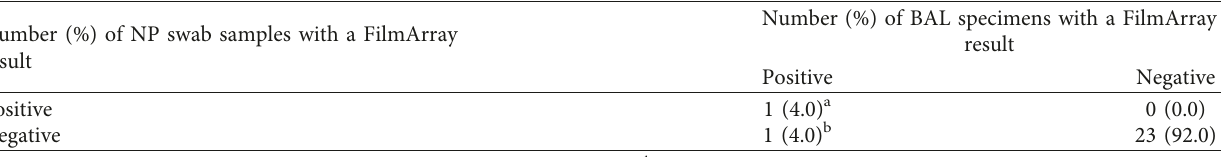
BAL, bronchoalveolar lavage; NP, nasopharyngeal; a rhinovirus/enterovirus ( n � 9), parainfluenza type 3 ( n � 2), coronavirus HKU1 ( n � 1), coronavirus NL63 ( n � 1), parainfluenza type 1 ( n � 1), human metapneumovirus ( n � 1), Bordetella pertussis ( n � 1), influenza A H3 ( n � 1), coronavirus OC43 and rhinovirus/enterovirus ( n � 1), and adenovirus, coronavirus 229E, and rhinovirus/enterovirus ( n � 1); b rhinovirus/enterovirus ( n � 6) and coronavirus HKU1 ( n � 2); c rhinovirus/enterovirus ( n � 2), coronavirus HKU1 ( n � 1), parainfluenza type 2 ( n � 1), and respiratory syncytial virus ( n � 1). Table 4: Comparison of FilmArray respiratory panel using paired nasopharyngeal swab and BAL samples collected from immuno- competent hosts ( n �